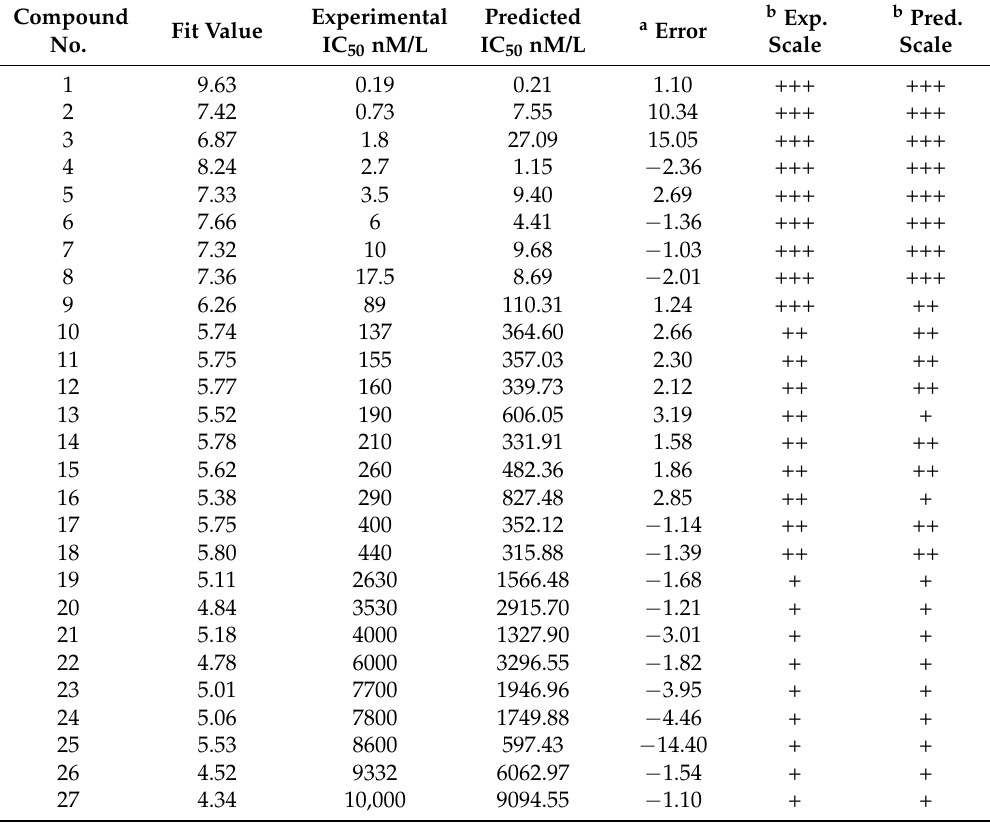
a Error: ratio of the predicted activity (Predicted IC 50 ) to the experimental activity (Experimental IC 50 ) or its negative inverse if the ratio is <1. b Activity scale: IC 50 < 100 nM/L = +++ (active), 100 nM/L < IC 50 < 500 nM/L = ++ (moderate active),